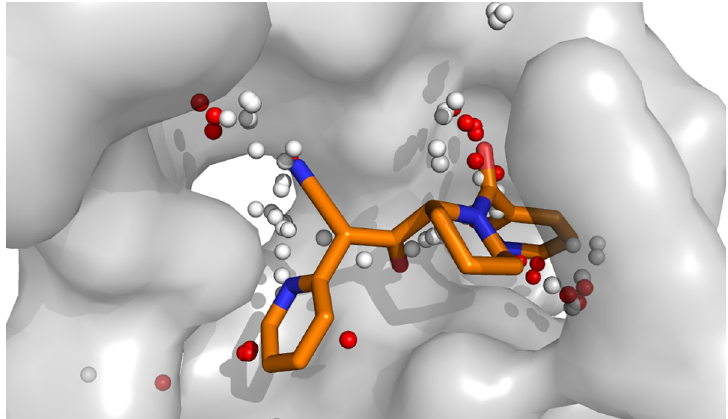
Fig 10. Comparison of the locations of alpha spheres and compound 18. Red alpha spheres indicate hydrophilic type of atoms and white hydrophobic groups favoured by the binding site regions.